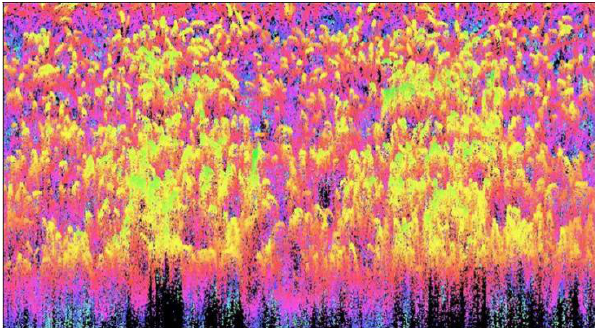
Figure 1. A sample 3D point cloud acquired over a wheat plot. The random spacing between plants,